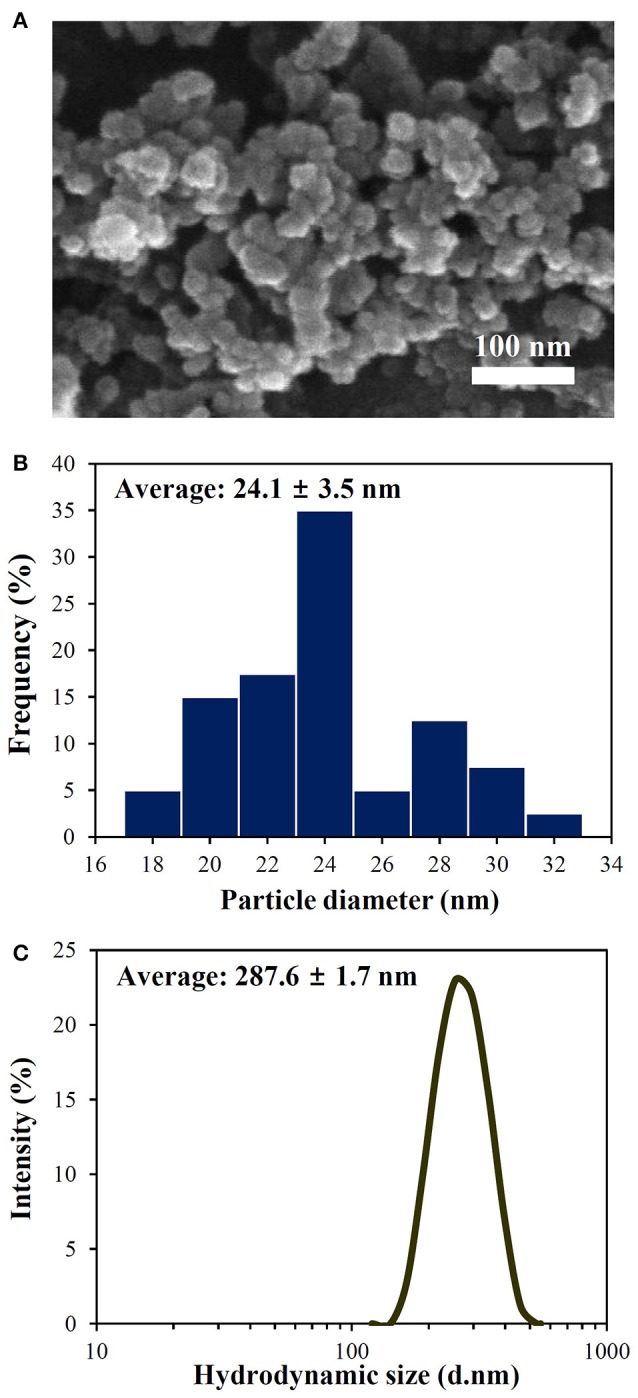
(A) SEM image, (B) size distribution of primary particles, and (C) hydrodynamic diameters of SiO2 NPs in DW. Primary particle size distribution was measured by randomly selecting 200 particles from the SEM image.